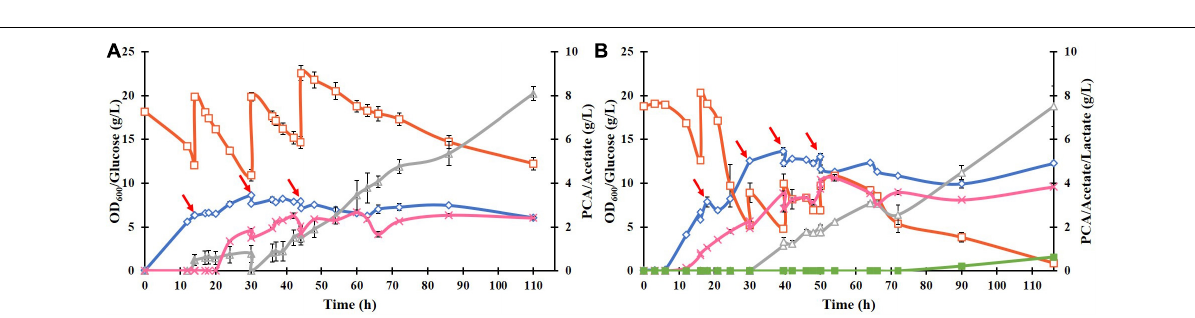
FIGURE 4 | Fed-batch cultivation of E. coli ATCC 31882-DSD in 1 liter of the modified M9 medium using a feed of: (A) glucose only, and (B) glucose and NH 4 Cl. The cultivations were performed in duplicates. Symbols: cell density measured as OD 600 ( ♦ ), concentrations of glucose ( (cid:3) ), PCA (x), acetate ( (cid:52) ), and lactate ( (cid:4) ). The cells were induced for expression of DSD using 0.1 mM IPTG at the start of the cultivation. The feed of approximately 10 g glucose (and 2 g NH 4 Cl) in 50 mL solution was added at discrete time points indicated by red